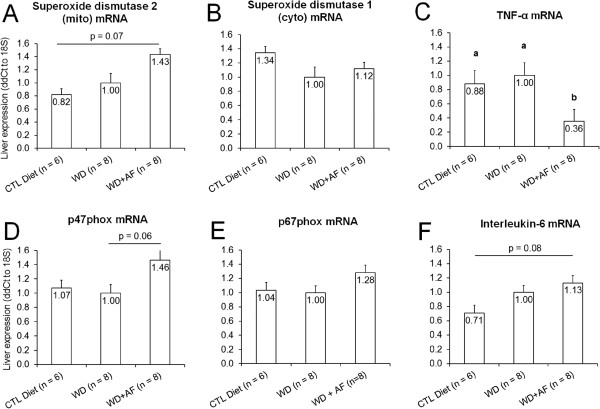
Effects of CTL, WD, and WD + AF feeding on SOD2 mRNA (A), SOD2 mRNA (B), Tnf-α mRNA (C), p47phox mRNA (D), p67phox mRNA (E), and IL-6 mRNA (F). WD + AF rats experienced a decrease in liver Tnf-α mRNA expression (C) compared to WD and CTL rats; WD + AF rats tended to increase liver SOD2 mRNA (A) and Il-6 mRNA compared to CTL (F) rats; WD + AF rats tended to increase liver p47phox mRNA compared to WD (C) rats. Abbreviations and symbols: CTL = control low-fat/low-sugar 14% diet, WD = Western diet, WD + AF = Western diet + anti-inflammatory supplement; In C, different superscript letters represents differences between groups (a > b, p < 0.05).